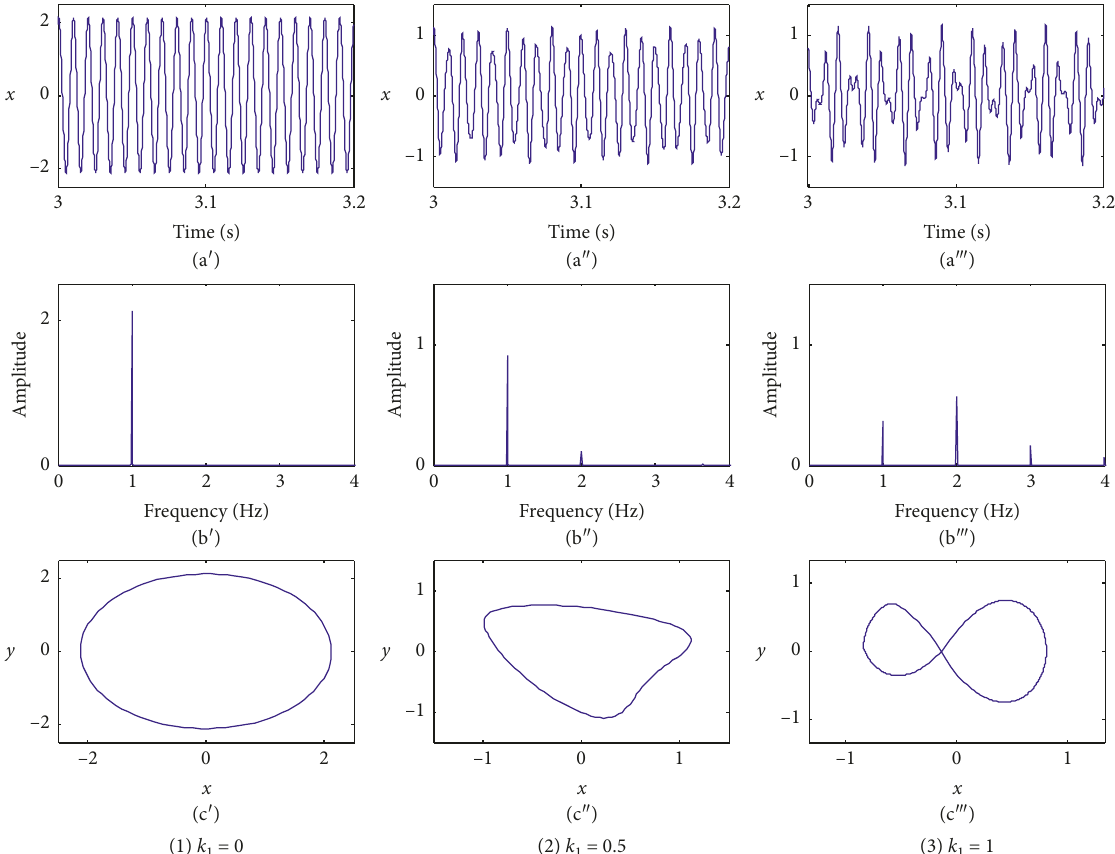
Figure 3: Dynamic response of rubbing stiffness change to the system.